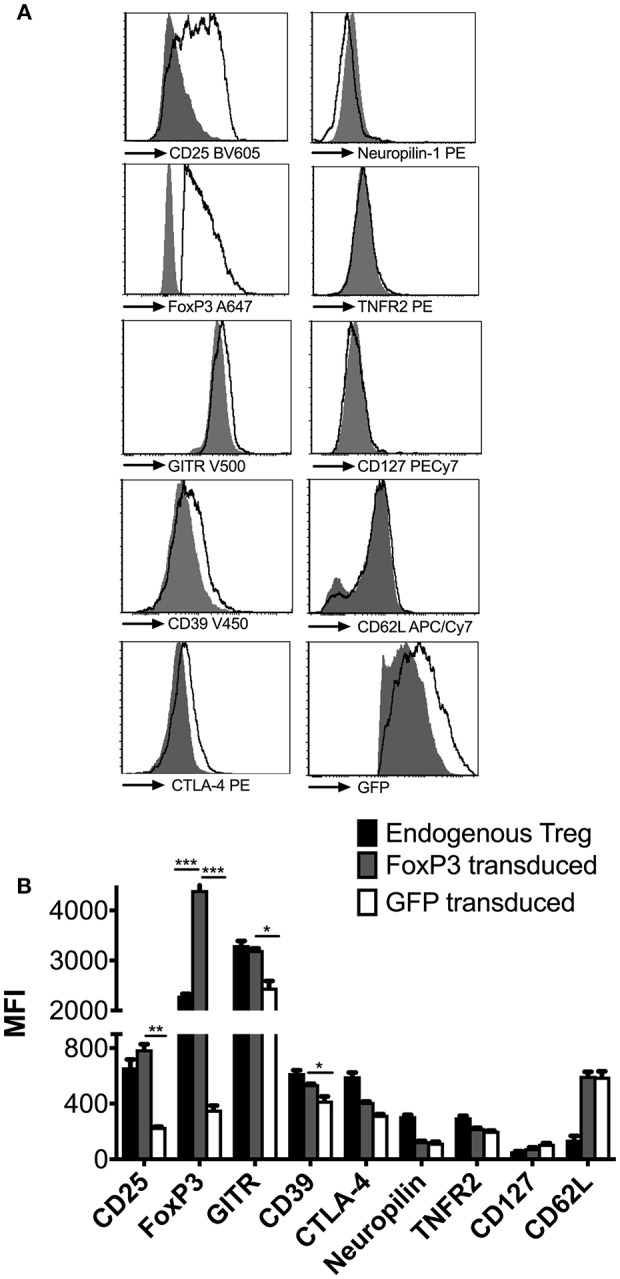
Phenotypic analysis of reprogrammed FoxP3 expressing Treg like cells. (A) FoxP3 transduced cells were adoptively transferred into wt BALB/c mice and re-isolated 2 days later to characterize them under in vivo conditions (empty histograms). Control GFP vector transduced cells (filled histograms) were also phenotyped for comparison. Expression levels of CD25, FoxP3, GITR, CD39, CTLA-4, NRP-1, TNFR2, CD127, CD62L, and GFP were quantified. (B) Median fluorescent intensity (MFI) of the above markers were compared between endogenous tTreg (black bars), FoxP3 transduced cells (gray bars) and GFP transduced cells (white bars). Data is representative of 2 samples and at least 2 independent experiments. *P < 0.05, **P < 0.01, ***P < 0.001.